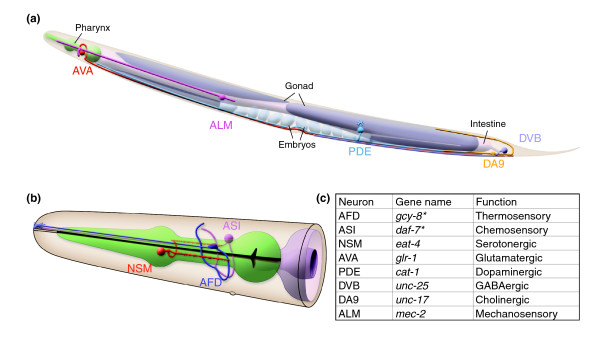
Pan-neural datasets detect neuron-specific transcripts. A representation of transcripts enriched in the larval pan-neural dataset and a subset of the neurons in which these genes are expressed. (a) Lateral view of an adult worm depicting selected neurons. Ventral is down, anterior is to the left. (b) Close-up of the adult head, showing the serotonergic neuron NSM and two sensory neurons, AFD and ASI. For simplicity, only one of the two pairs of neurons is diagrammed. The pharynx is colored green and the anterior end of the intestine is gray. (c) Table displaying representative genes enriched in the larval pan-neural dataset and expressed in each indicated neuron. Asterisks denote exclusive expression in the listed cell type. (Artwork courtesy of Zeynep Altun, Chris Crocker and David Hall at WormAtlas [120].)